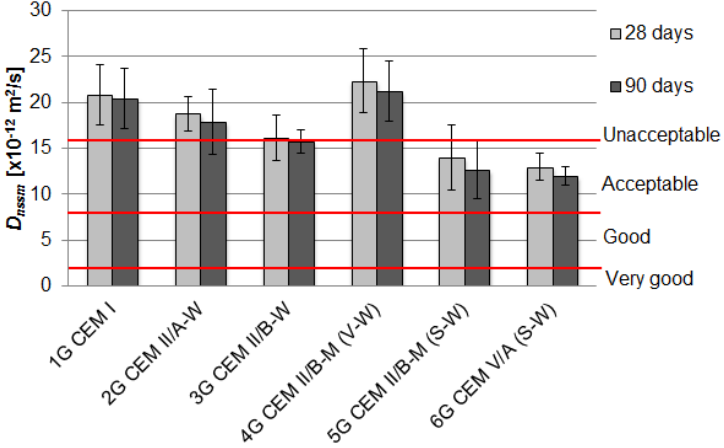
Figure 1. The influence of type of cement on the chloride migration coefficient D nssm for concrete with granodiorite aggregate.